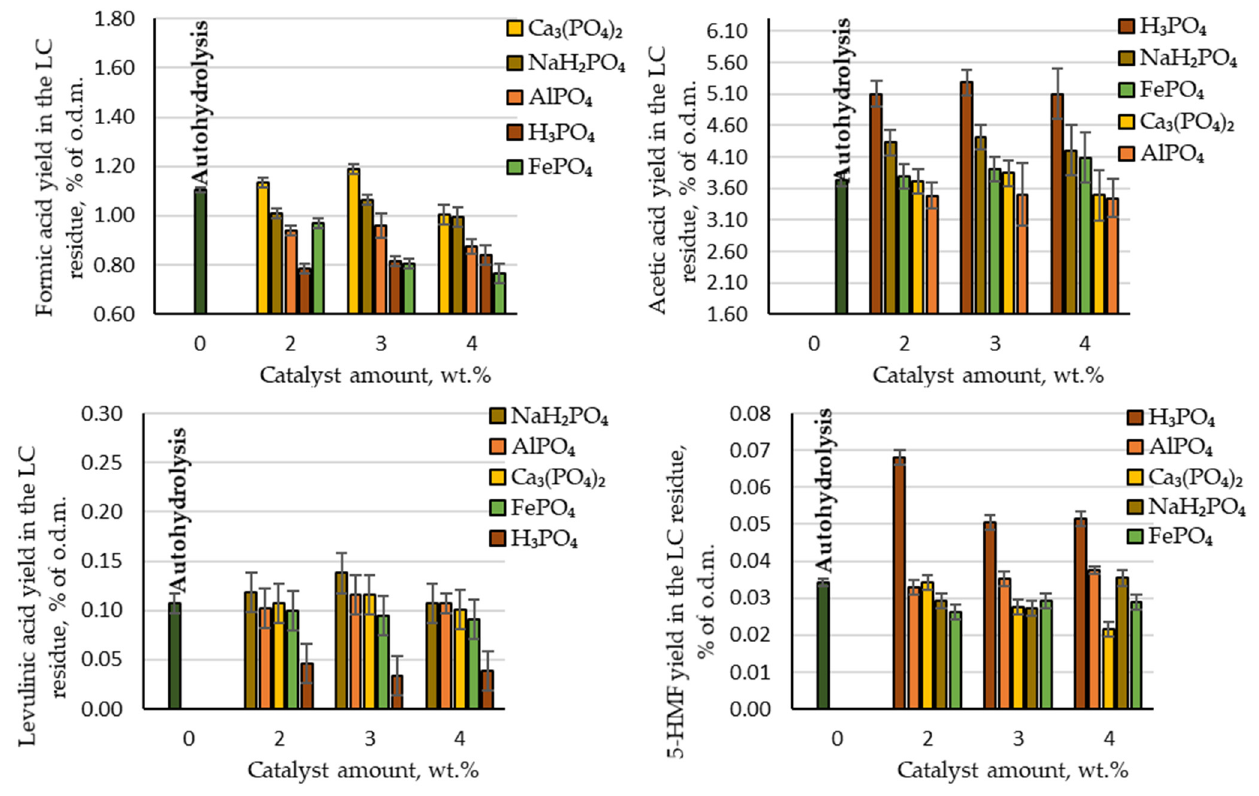
Figure 4. Yields of hydrolysis by-products (formic acid, acetic acid, levulinic acid and 5-HMF) in the LC residue depending on the catalyst amount.